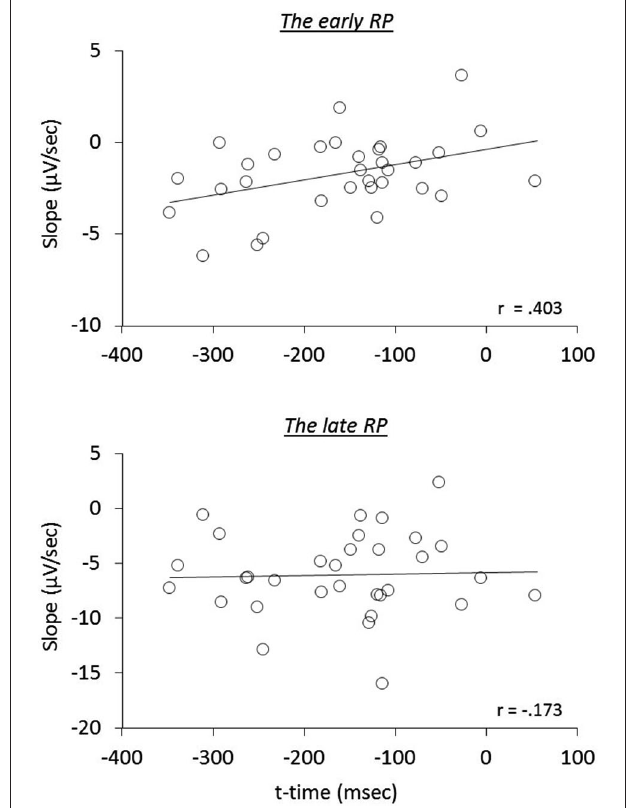
FIGURE 3 | The relation of the RP slopes to reported time of the tone during the operant-T task .